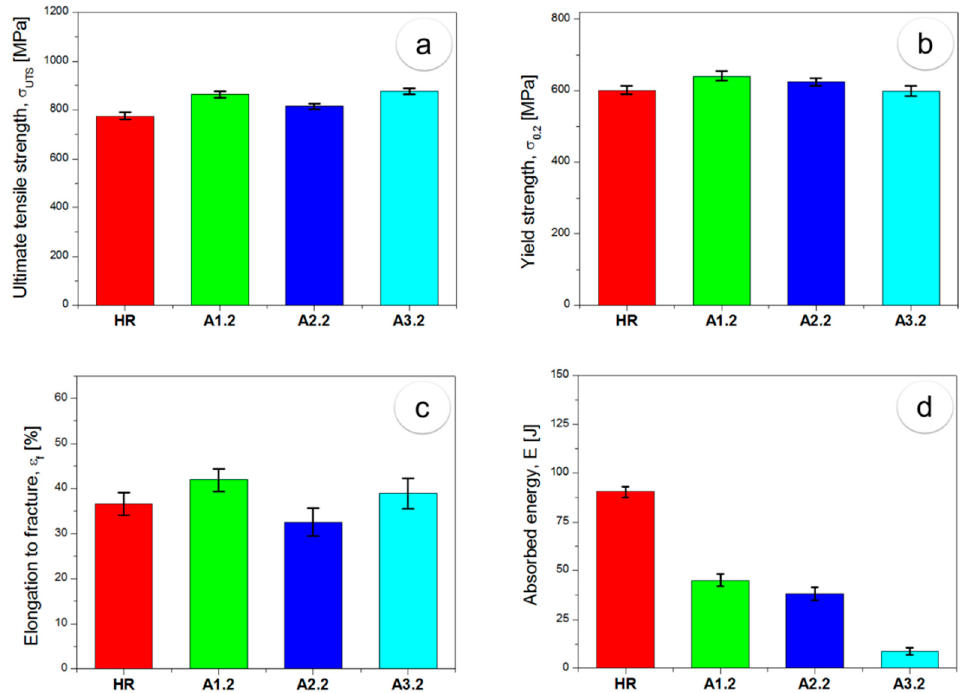
Figure 9. Comparative representation of mechanical properties for the hot-rolled ( HR ) and long-duration aging treatments A1.2 , A2.2, and A3.2 states for ultimate tensile strength ( a ), yield strength ( b ), elongation to fracture ( c ), and absorbed energy ( d ).